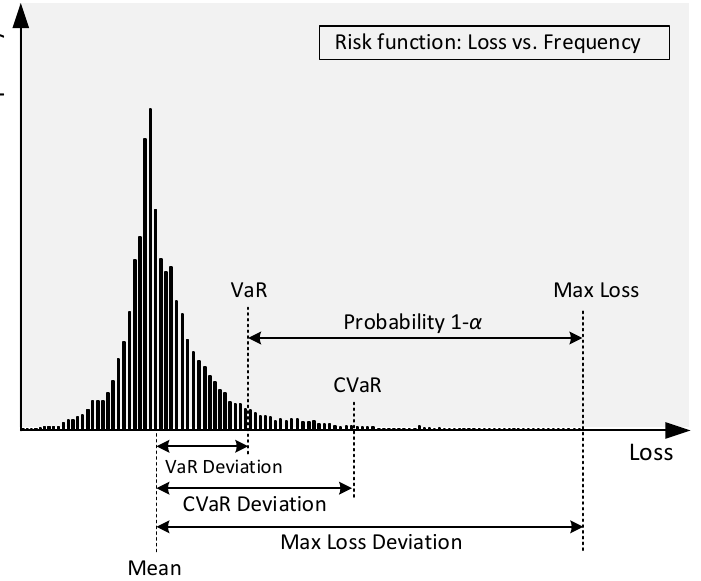
Figure 3. VaR, CVaR and deviations adapted from Sarykalin et al.